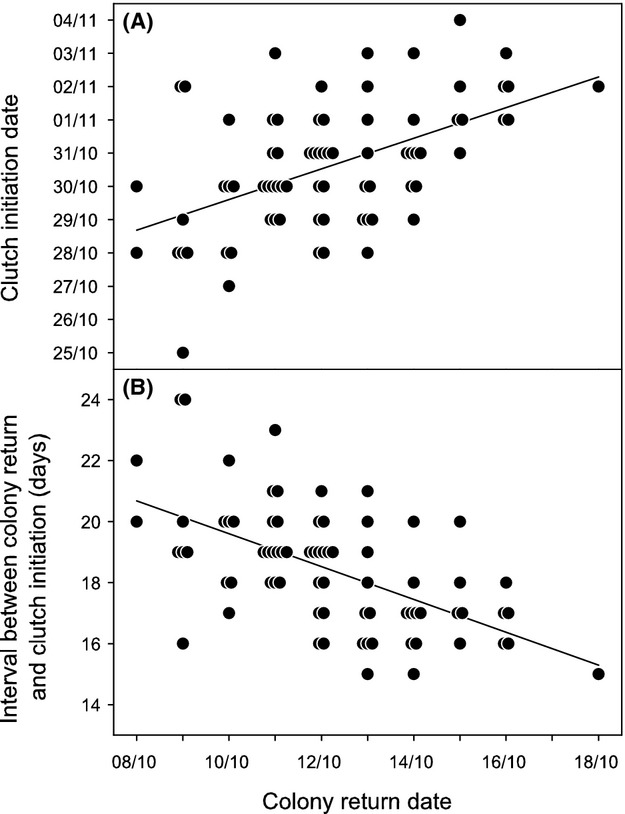
(A) Individual female clutch initiation (i.e., A-egg laying) date and (B) time interval (in days) between colony return and clutch initiation according to the date of return to the colony after winter in southern rockhopper penguins Eudyptes chrysocome. Lines are linear regressions and identical points have been spread out slightly for clarity. n = 75 females.